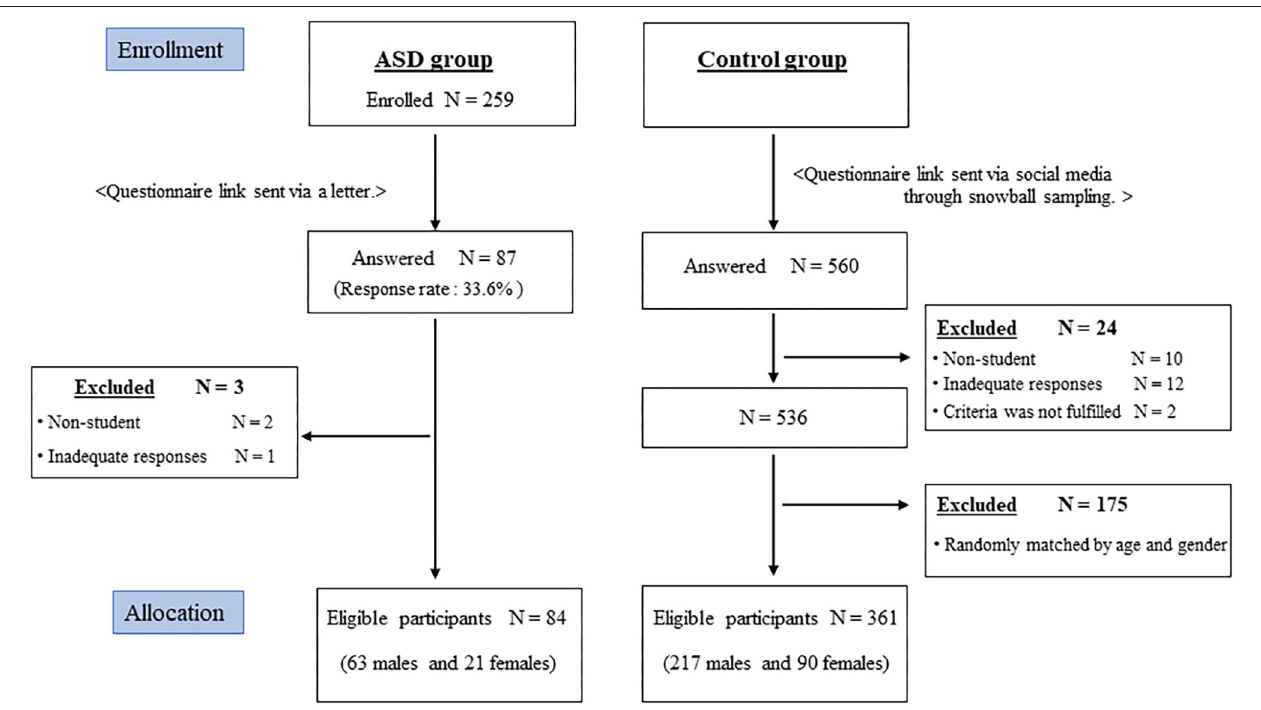
FIGURE 1 | Flow diagram of the process of sampling the autism spectrum disorder group and a matched control group. ASD, autism spectrum